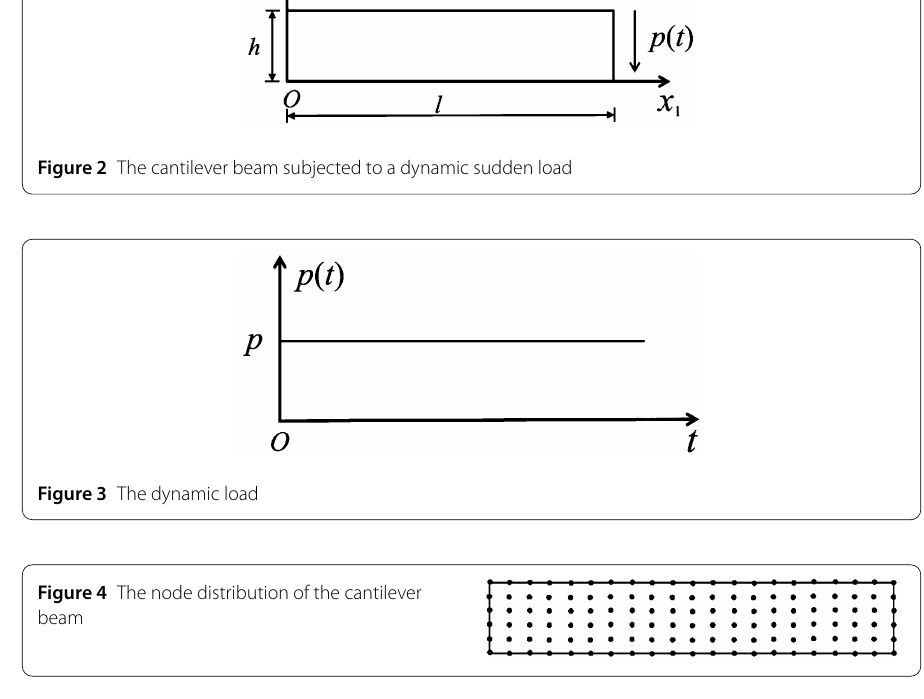
Fig. 3, ignoring the static load, the plane stress method is adopted to calculate. The dis- placement along the x 1 direction is u . The displacement along the x 2 direction is v . The initial conditions are u 0 = ˙ u 0 =